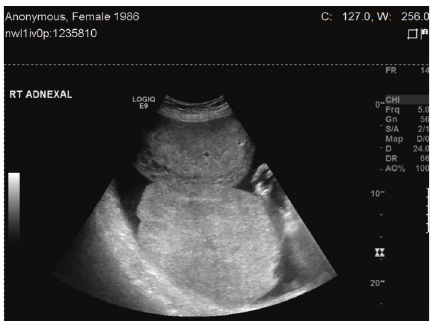
Figure 1: Pelvic ultrasonography revealing a large right-sided adnexal mass of heterogeneous appearance.